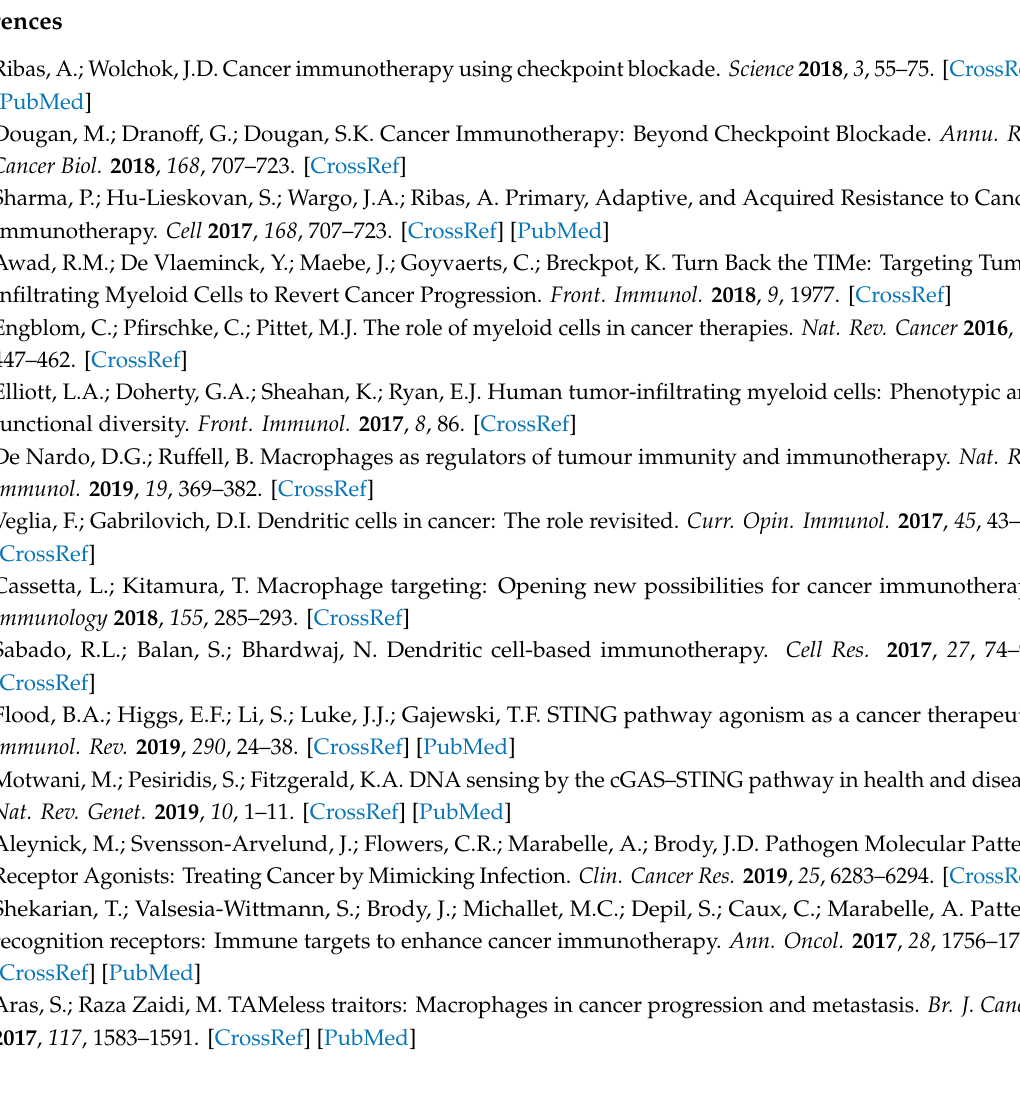
Figure S1: Correlation between CXCL11, GBP1, and IDO1 signature score and abundance of immune cells deconvoluted with CIBERSOR., Figure S2: Signature Score in melanoma patients before anti-PD-1 treatment, Table S1: Expression of MA signature genes Cxcl11, Gbp1 and Ido1 in B cells, NK cell, CD4 and CD8 T cells upon activation., Table S2: TCGA study abbreviations and corresponding study names, Table S3: Primer